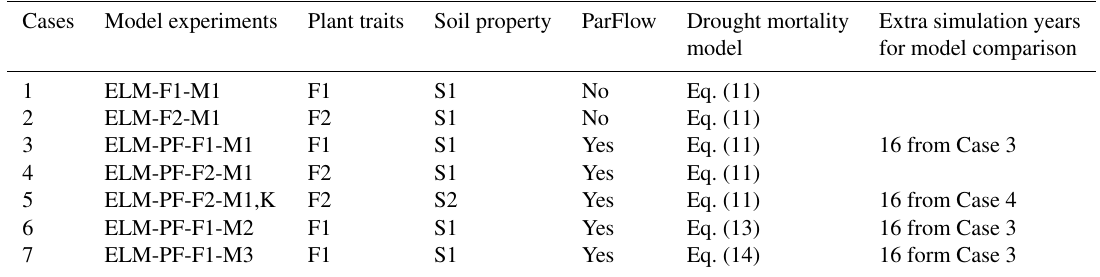
Table 1. Definition of model experiments with ELM, PF, F, and M denoting the E3SM land model, ParFlow, different parameters for plant traits, and different mortality models, respectively. K in the experiment name of Case 5 indicates that the soil property derived from Kupers et al. (2019b) is used. An extra 16 years of simulation were conducted for four experiments.